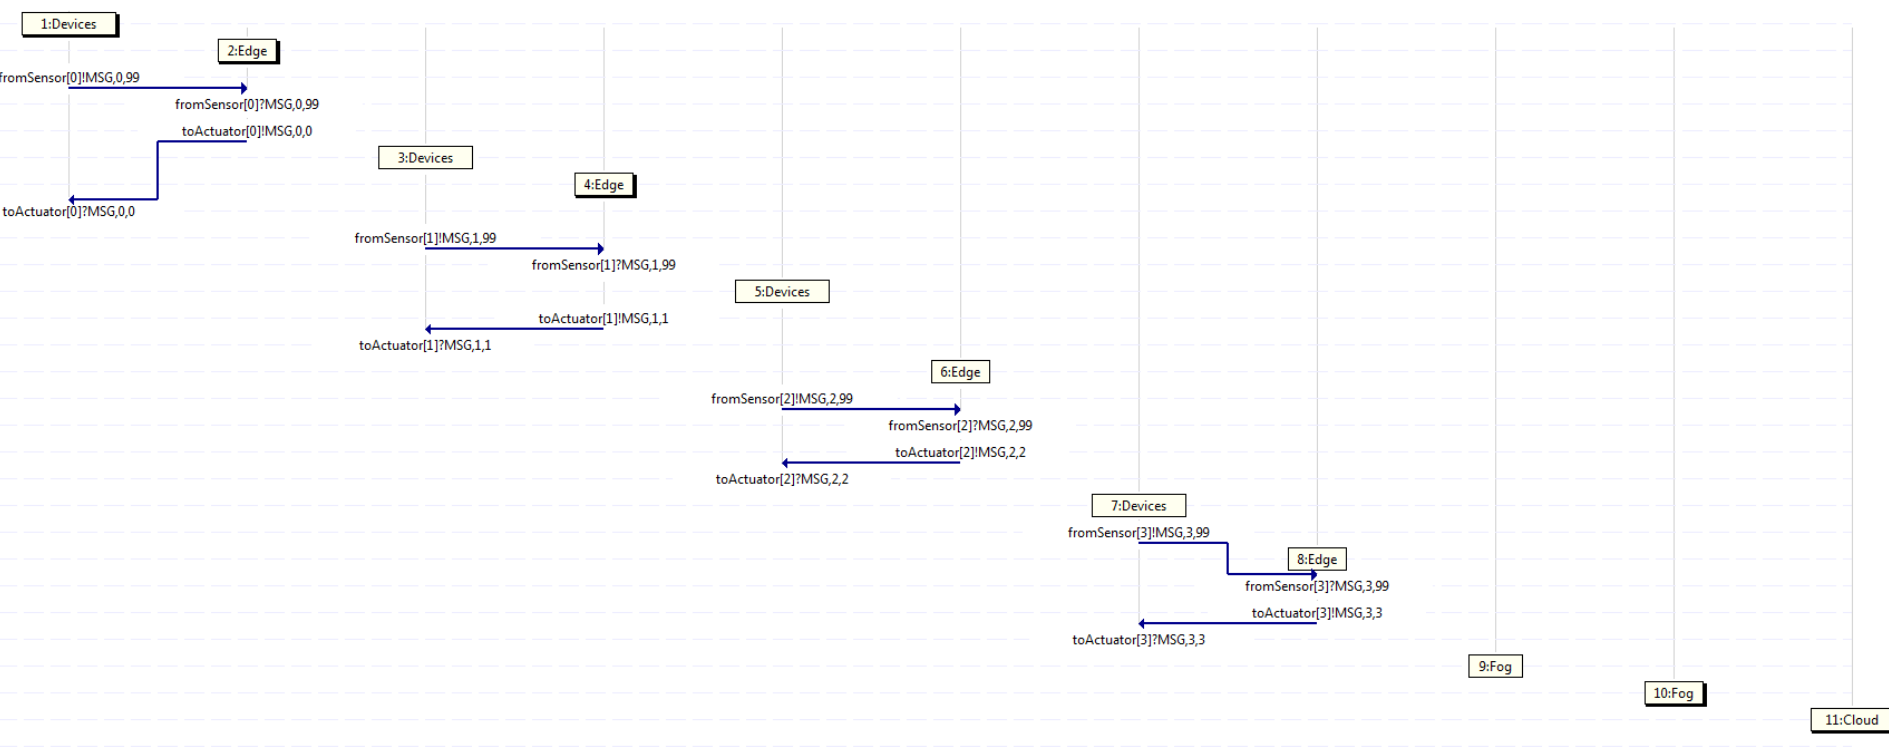
Figure 6. Capture where only edge servers deal with all